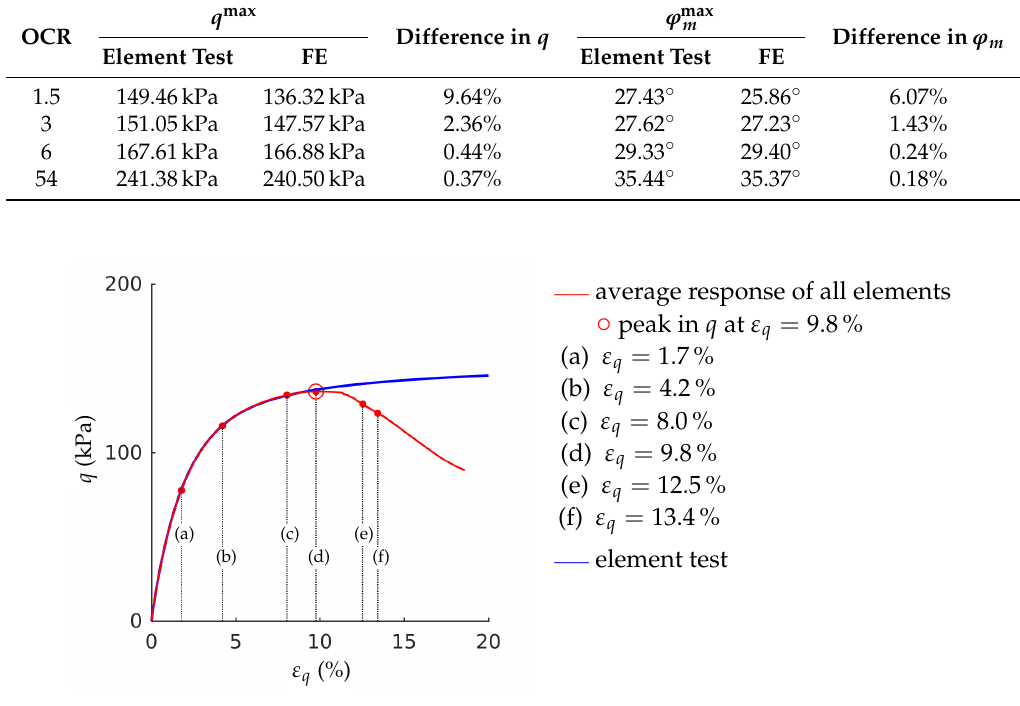
Figure 10. OCR = 1.5: The global deviatoric strain ε q marked with ( a – f ) corresponds to Figure 9a–f.